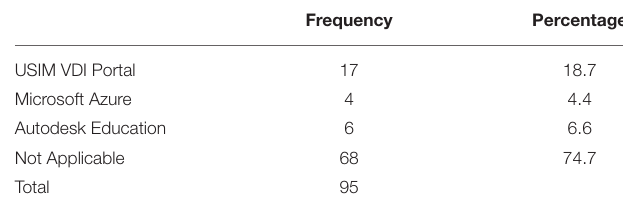
TABLE 13 | Access to software that staff know.